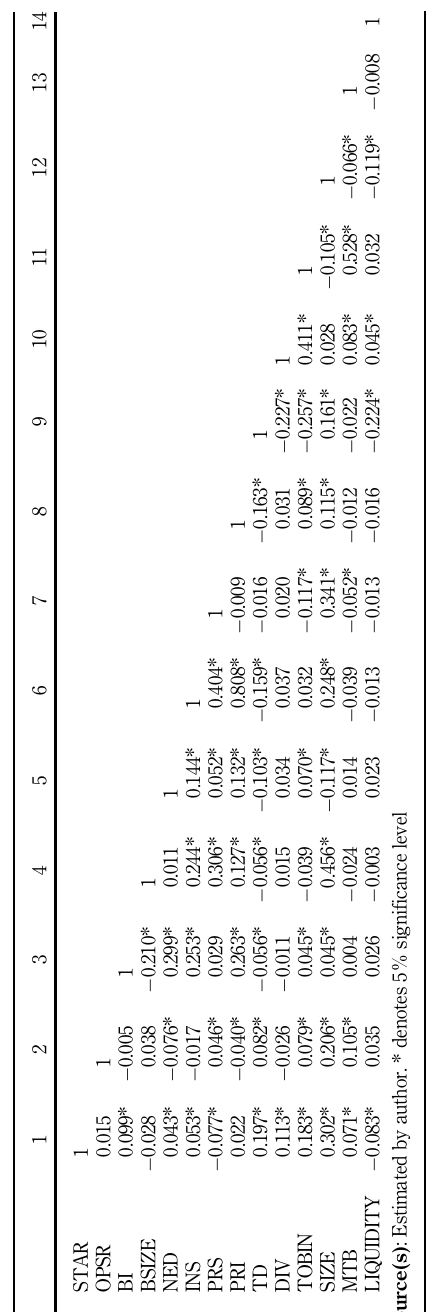
Table 2. Pearson ’ s correlation